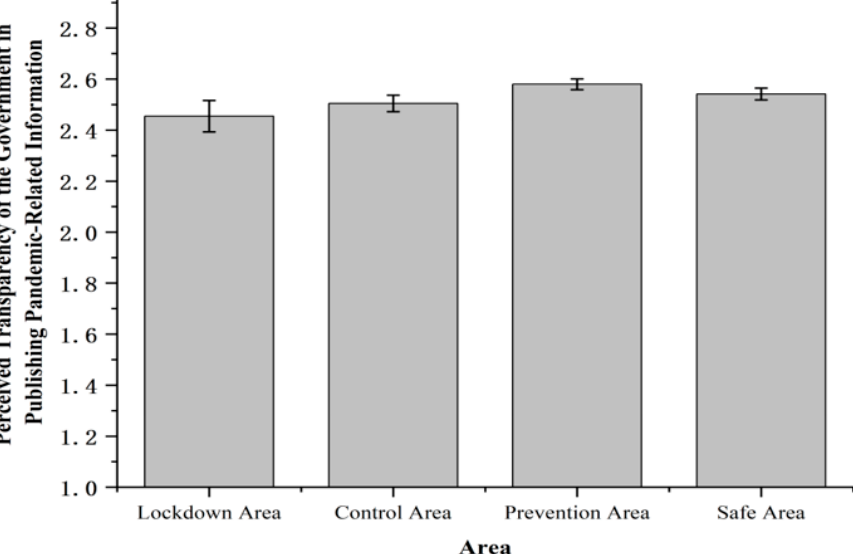
Figure 5. Perceived transparency of the government in publishing pandemic-related information. Note: The rating of the transparency of the government in publishing pandemic-related information was measured on a 3-point scale (1 = low, 2 = medium, 3 = high). Error bars represent standard errors.